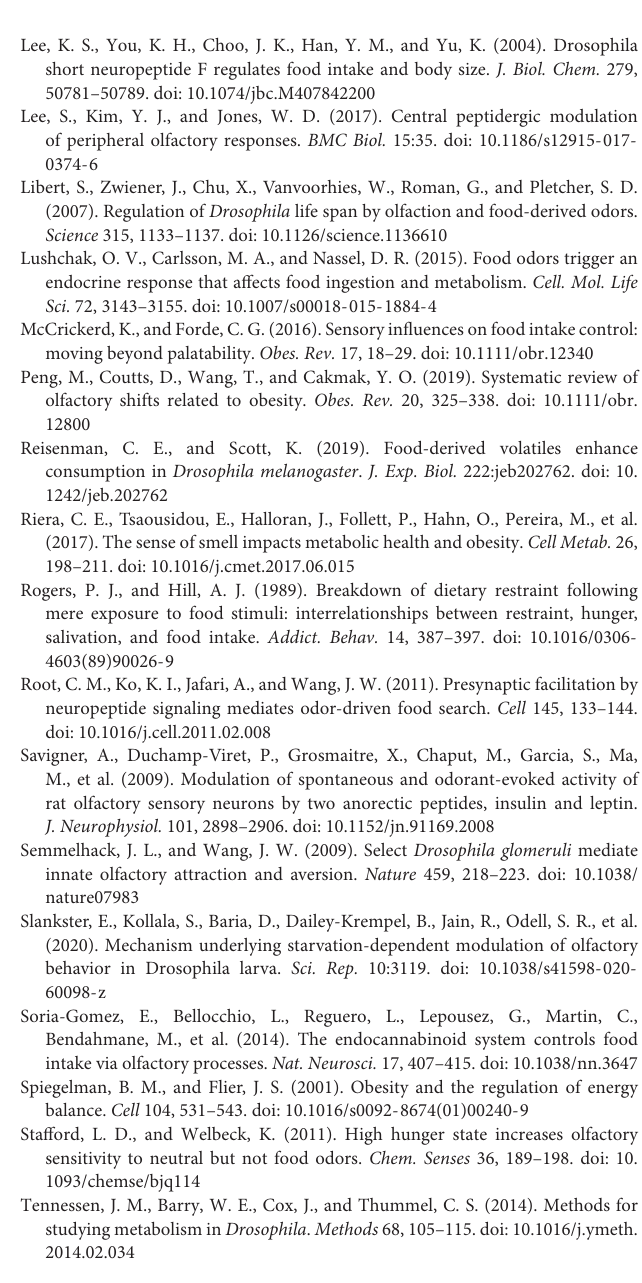
Supplementary Figure 2 | Blocking OSNs has no function in nutrient preference. Orco 1 mutant flies and w 1118 flies all prefer 5% sucrose with 5% yeast extract diet than 5% sucrose